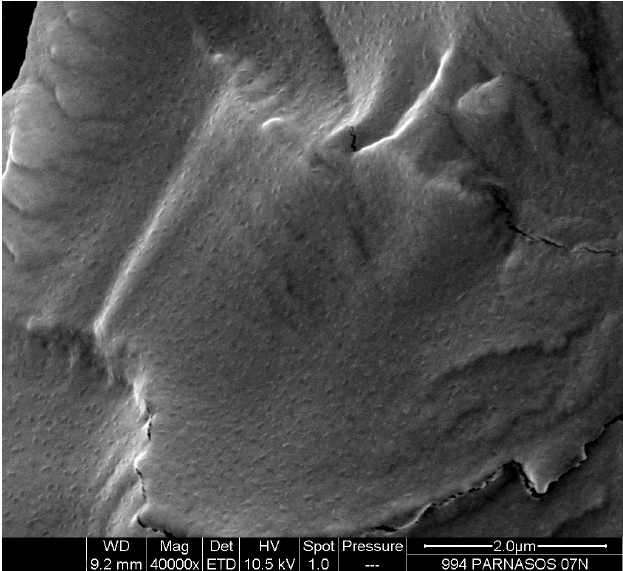
Figure 7. FESEM micrograph of cryogenical fracture surface of TiO 2 /poly (carbonate urethane) nanocomposite film sample.